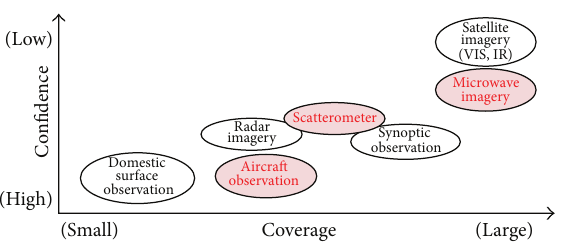
Figure 1: Confidence and coverage of individual observations. Synoptic observation refers to the surface observation data from the Regional Basic Synoptic Network (RBSN) in the western North Pacific basin received through GTS (Global Telecommunication System). Shading indicates additional information received later (analysis